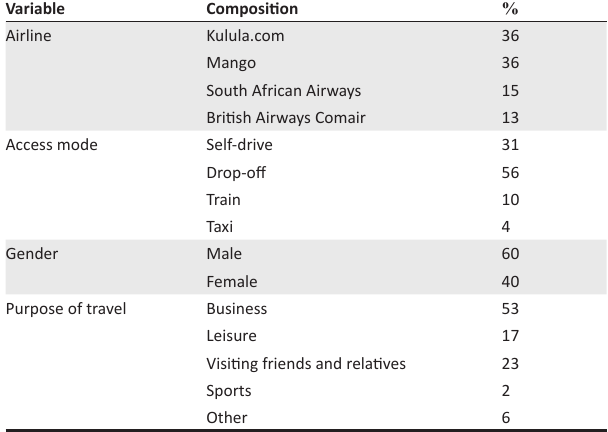
TABLE 2: Sample composition of